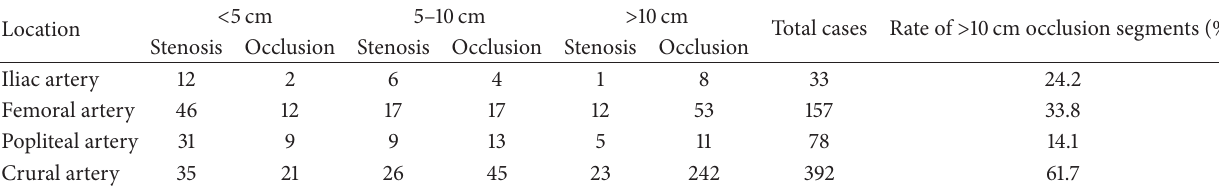
Table 3: Length and type of the lower limb artery lesion in 162 diabetic patients.